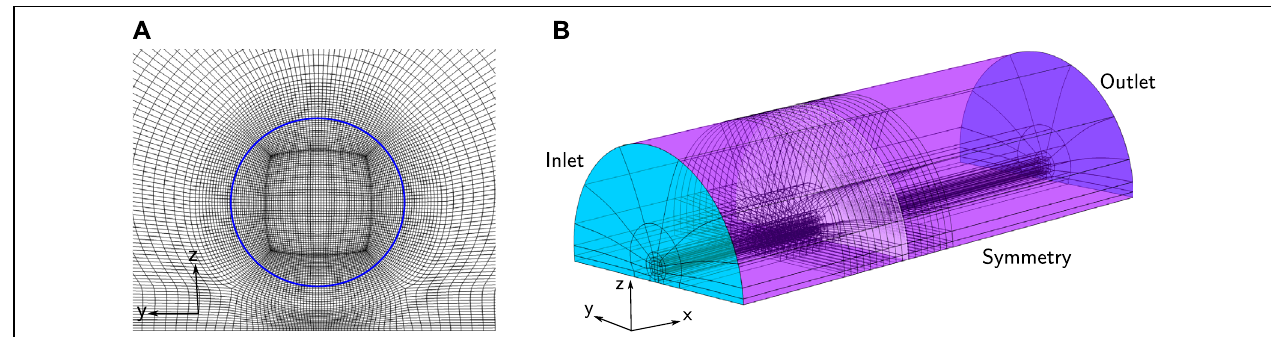
FIGURE 2 | Computational Domain: (A) Background mesh in the rotor plane on grid level 2. (B) Overall domain size and boundary conditions with rotor plane mesh in white.